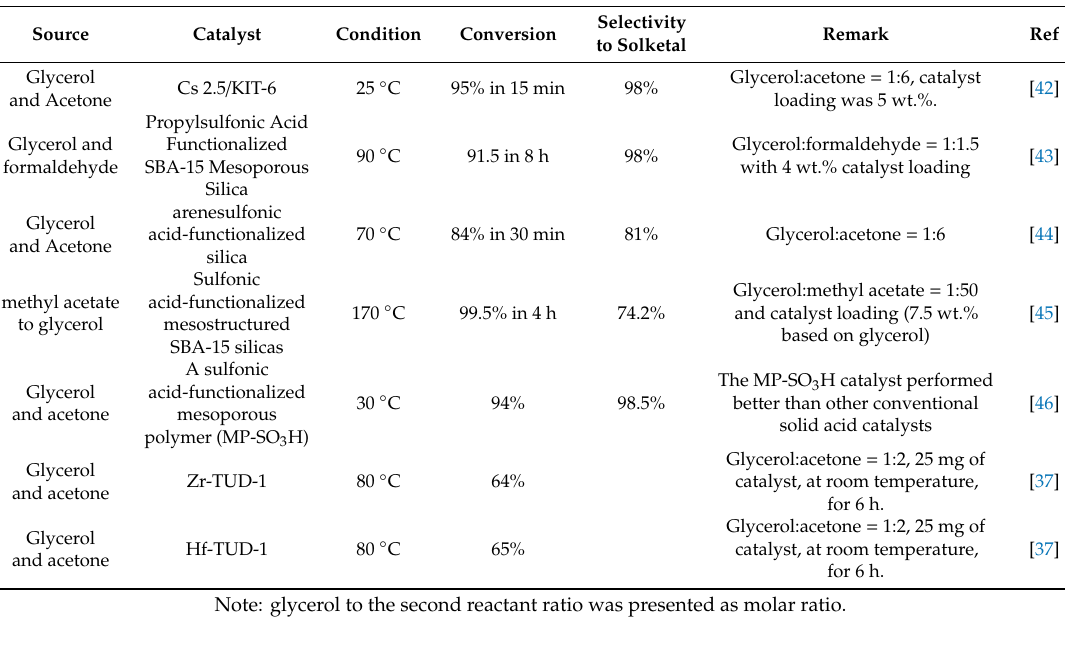
Table 4. Glycerol-to-solketal over mesoporous silica.